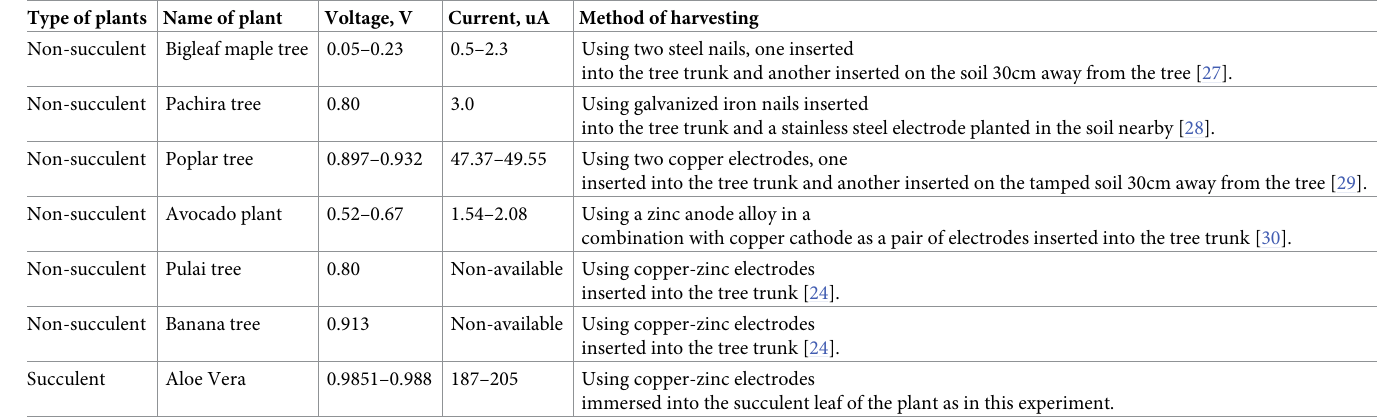
Table 3. Comparison of voltage and current harvested between different types of living plants with Aloe Vera. Type of plants Name of plant